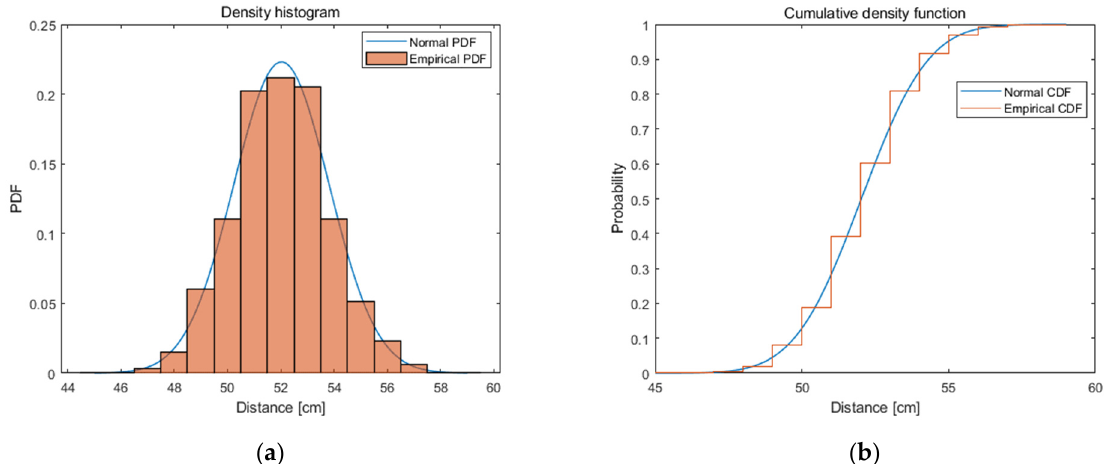
Figure 9. Example: ( a ) density histogram; and ( b ) CDF with distance.